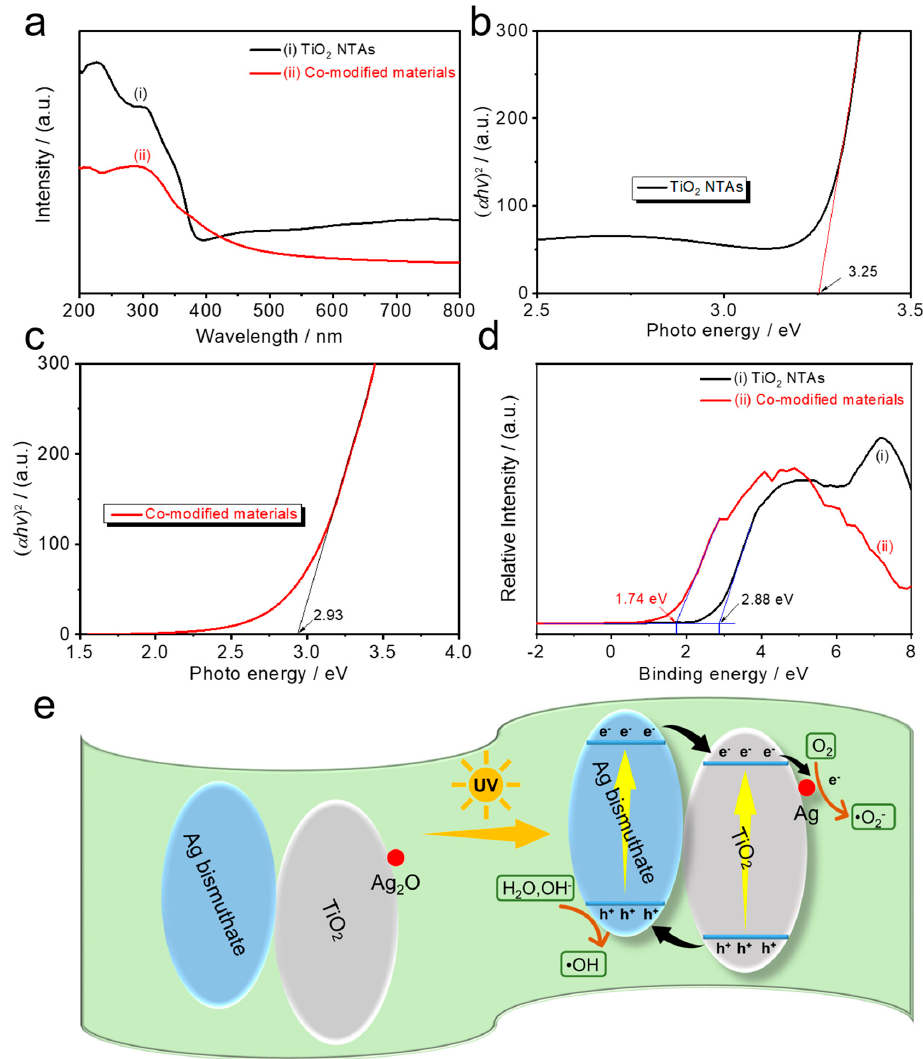
Figure 3. ( a ) Light absorption spectra, ( b , c ) transformed Kubelka–Munk function plotted against photon energy curves, and ( d ) XPS valance band edge of TiO 2 and co-modified materials. ( e ) Schematic view for electron–hole separations and energy band matching of co-modified TiO 2